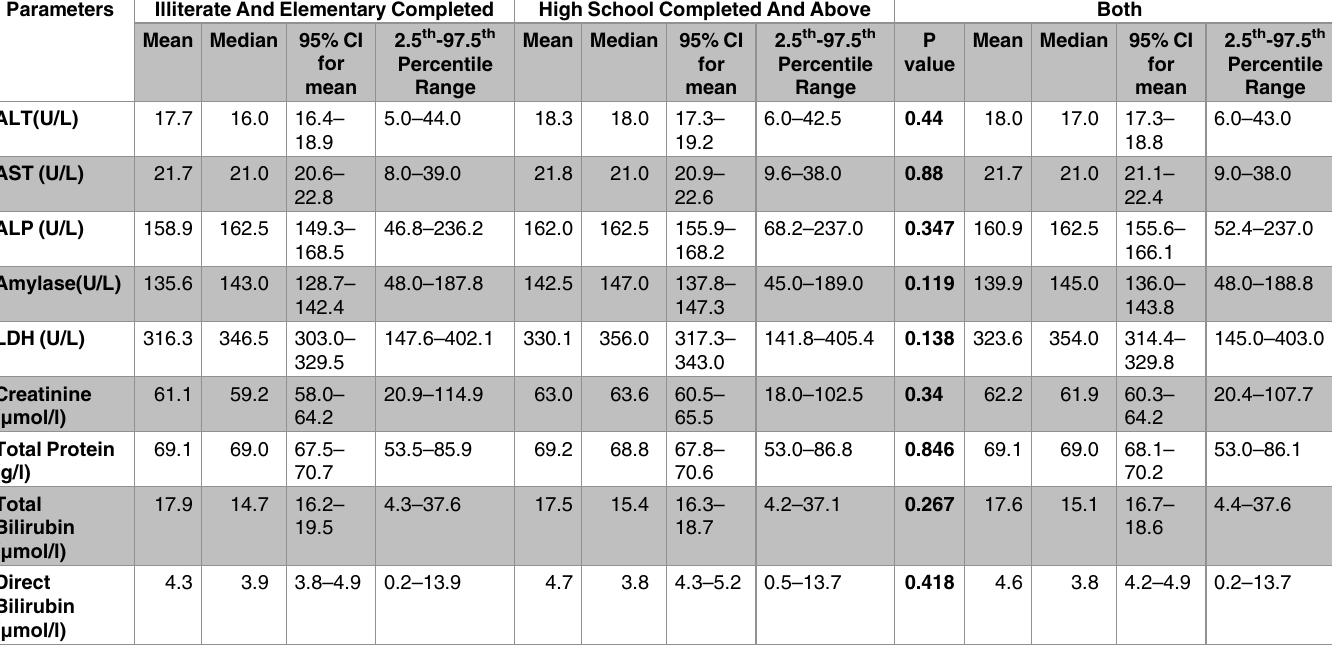
Table 4. Mean, median, 95% CI for mean and 2.5 th -97.5 th percentile of clinical chemistry referencevalues in relation to educational status of healthy adults in Gojjam, Zones, AmahraNational Regional State, Northwest